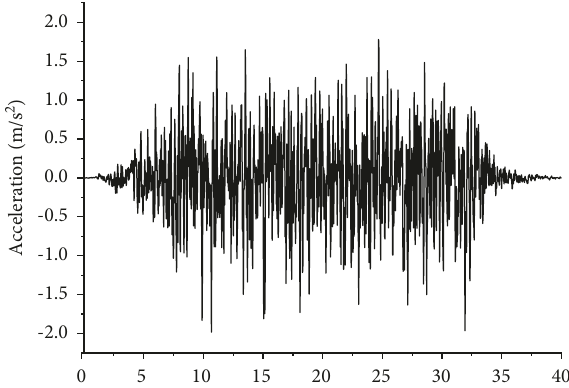
Figure 4: Artificial seismic waves generated using numerical analysis software.